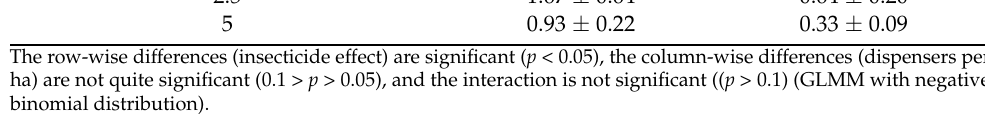
Table 5. Percent navel orangeworm infestation (mean ± SE, n = 8) from windrow samples from Nonpareil and pooled pollinizer varieties by insecticide and mating disruption (MD) treatment, 2008–2011. Mating Disruption Dispensers per ha Without Insecticide With Insecticide 2.5 1.67 ± 0.64 0.64 ± 0.20 5 0.93 ± 0.22 0.33 ± 0.09 The row-wise differences (insecticide effect) are significant ( p < 0.05), the column-wise differences (dispensers per ha) are not quite significant (0.1 > p > 0.05), and the interaction is not significant (( p > 0.1) (GLMM with negative binomial